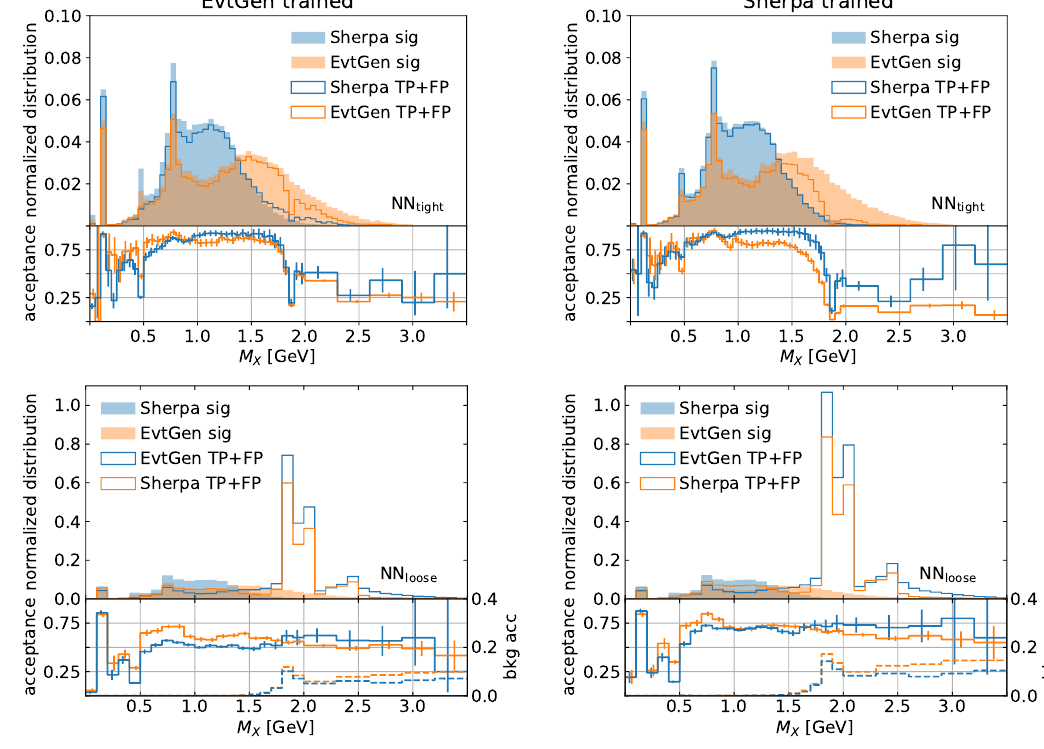
Figure 13 . M X distributions and signal acceptance for NN tight (top) and NN loose (bottom) trained on E VT G EN (left) and S HERPA (right) data. For NN the dashed lines in the lower panel show loose the background acceptance using the scale for the y -axis on the right. The distributions in the upper panels of each plot are normalized to the total number of signal events. A broader binning has been chosen to show the acceptance at M 2 GeV, where event statistics are X >